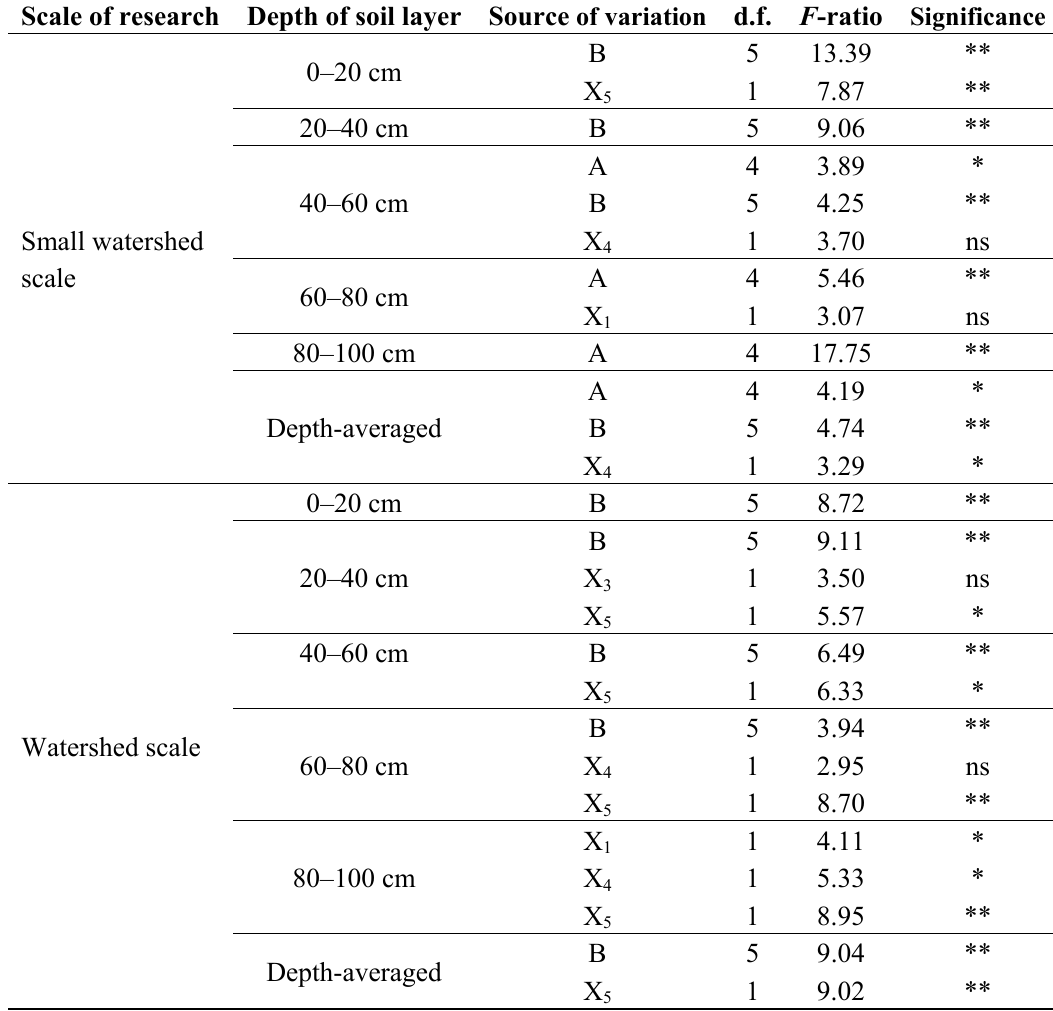
Table 5. ANOVA of stepwise regression, including qualitative